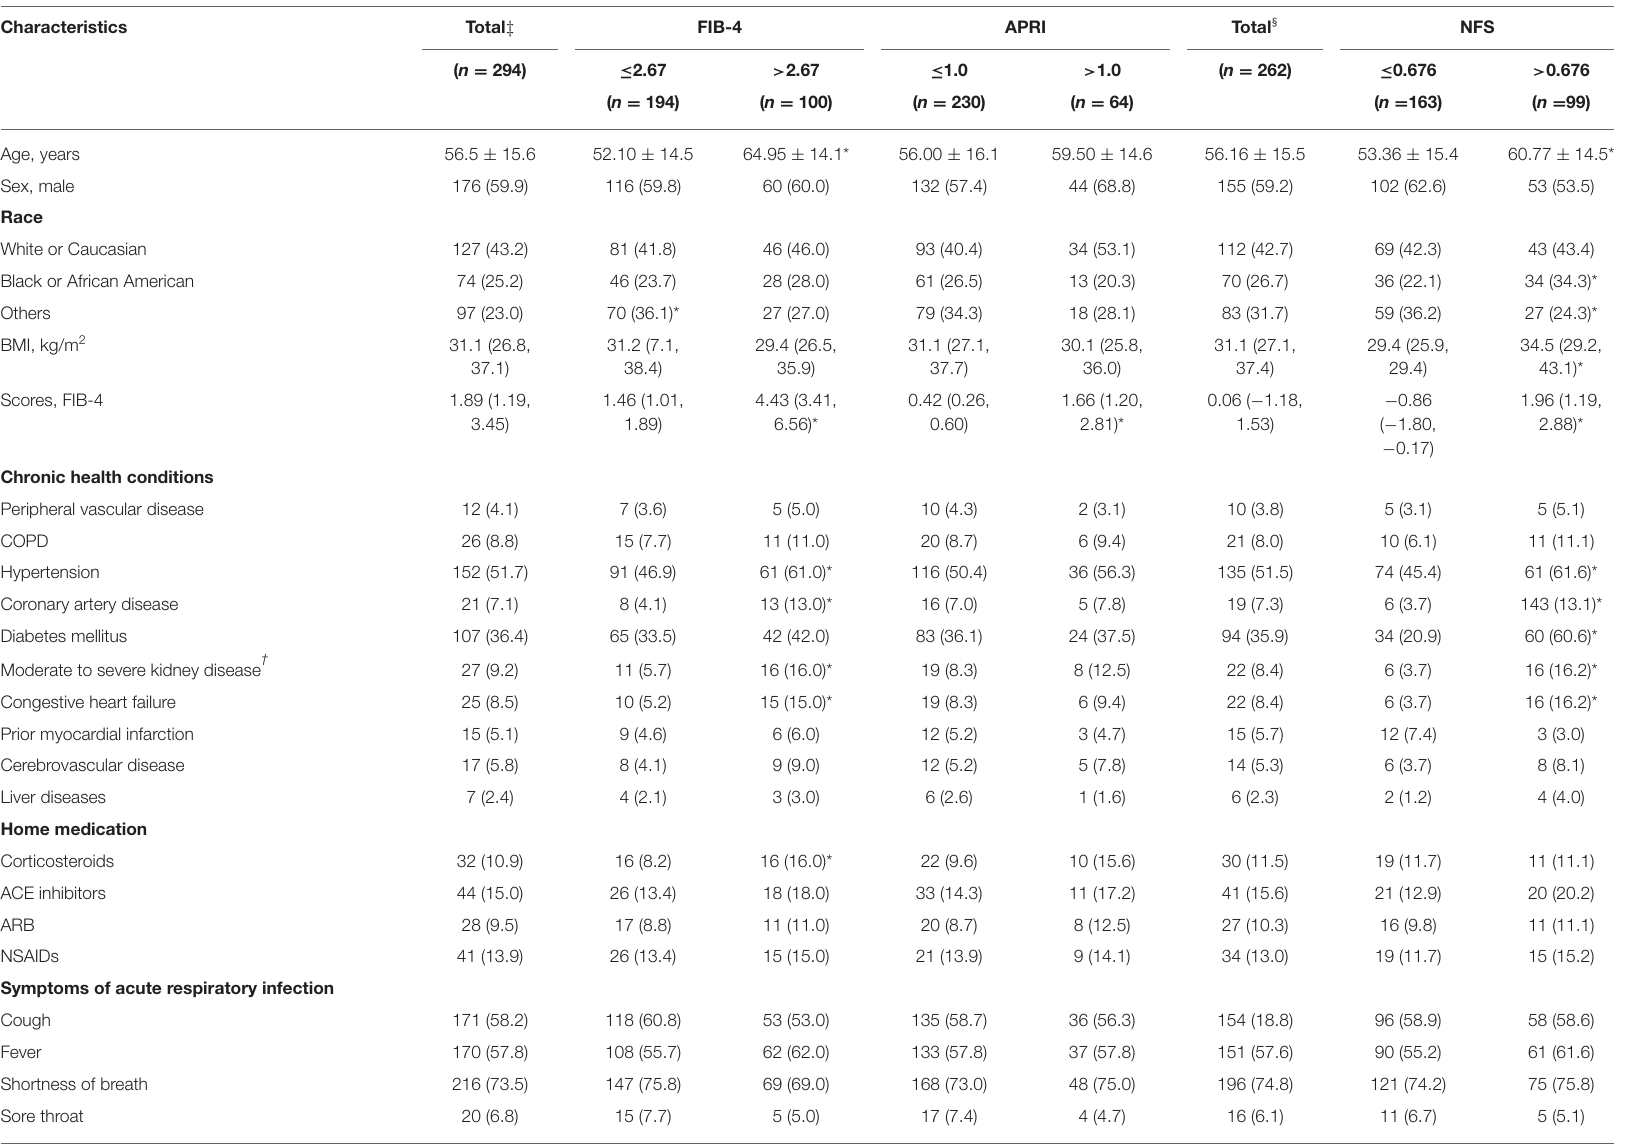
TABLE 1 | Baseline characteristics of included patients stratified by FIB-4, APRI, and NFS.